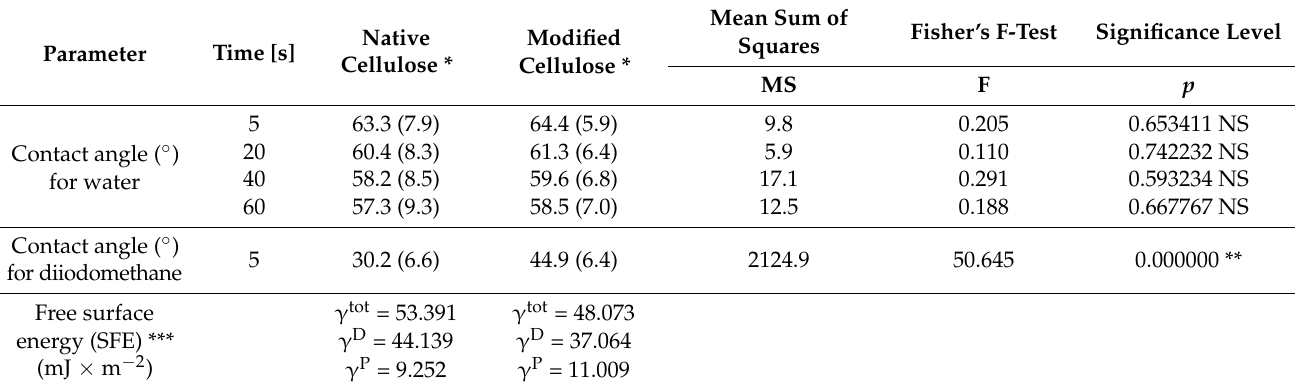
Table 3. Measurement of surface wettability and free surface energy of cellulose